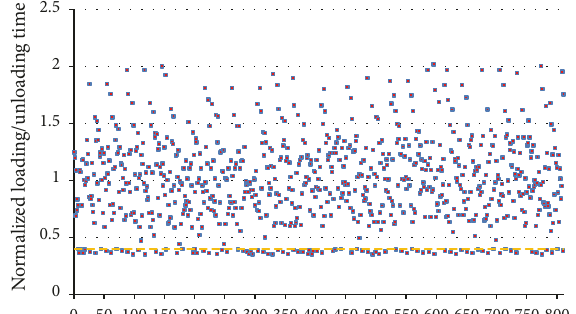
Figure 19: Historical train loading/unloading time distribution.